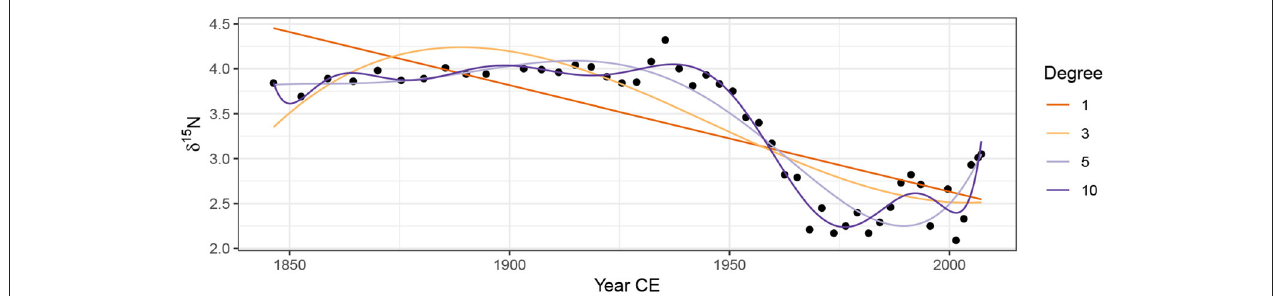
FIGURE 3 | Linear models with various orders of polynomial of the covariate Year fitted using ordinary least squares to the δ 15 N time series from Small Water. The degree of polynomial is indicated, with the degree 1 line equal to a simple linear regression